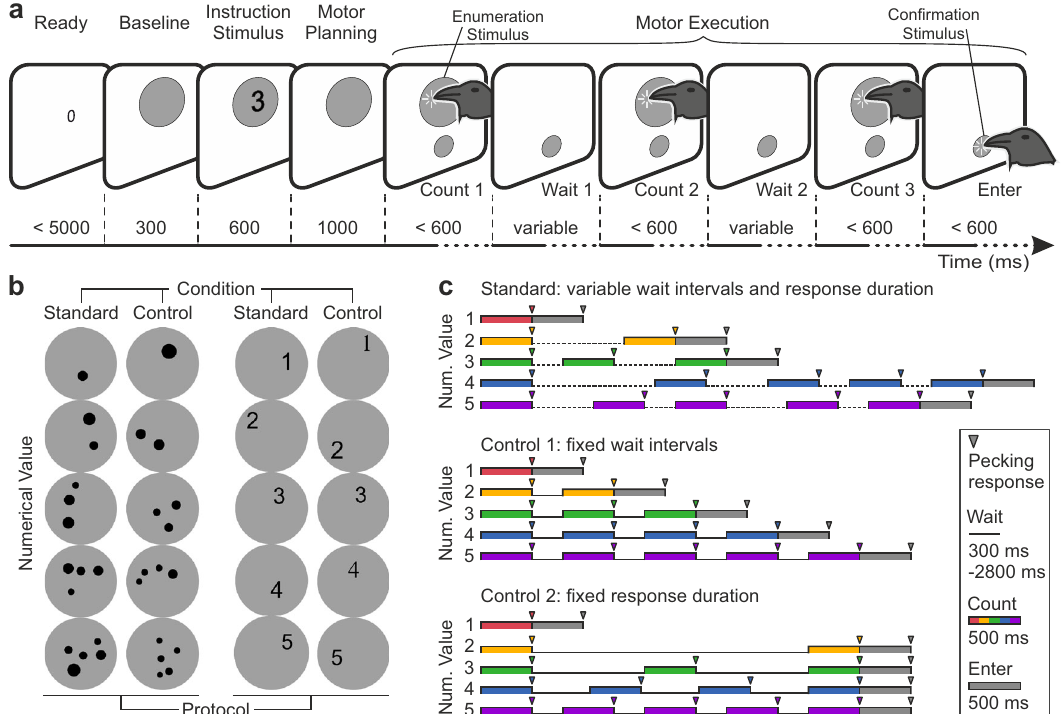
Fig. 1 | Crows performed an instructed number production task. a Number productiontask.Afterthecrowinitiatedatrialbypositioningitsheadinfrontofthe touch-sensitive monitor, an instruction stimulus appeared cueing the crow for 1 – 5 pecking responses (three pecks cued in the example shown). During a brief motor planningperiod,thecrowplannedtheimpendingnumberofpecks.Next,thecrow was prompted to peck the instructed number of times, with each unitary peck delivered in a pre-de fi ned epoch cued by enumeration stimuli shown at variable time points. Finally, the crow indicated the end of the response sequence by pecking at a con fi rmation stimulus ( “ enter key ” ). b Example instruction stimuli.